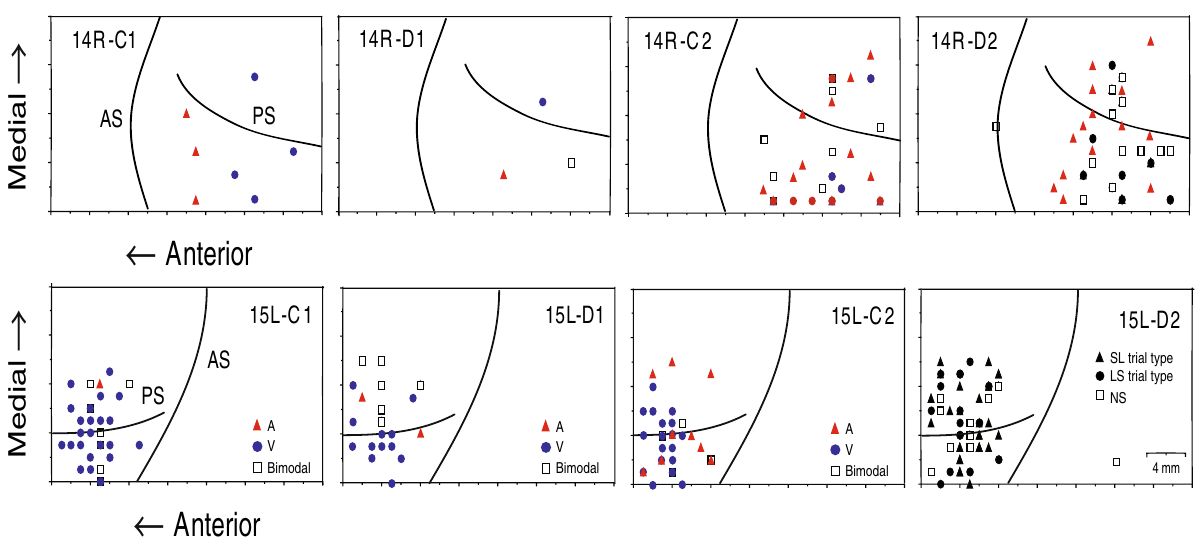
Figure 7. Recording sites. Cortical surface maps show penetration sites where C1-, D1-, C2-, and D2-responsive neurons were recorded in the right PFC of monkey M14 (top) and in the left PFC of monkey M15 (bottom). In the maps for C1-, D1- and C2-responsive neurons, symbols represent the sites where neurons responding to auditory (red triangles), visual (blue circles), and both auditory and visual (white squares) cues were found. In the maps for D2- responsive neurons, symbols indicate the sites where neurons showing selective D2 activity in the SL (black triangles) and LS (black circles) trials and nonselective D2 activity (white squares) were recorded. AS, arcuate sulcus; PS, principal